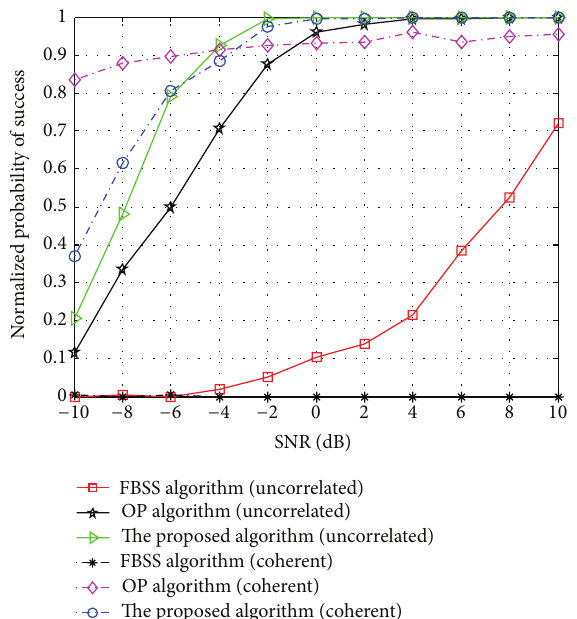
Figure 3: NPS of the DOA estimates versus input SNR for the uncorrelated and coherent